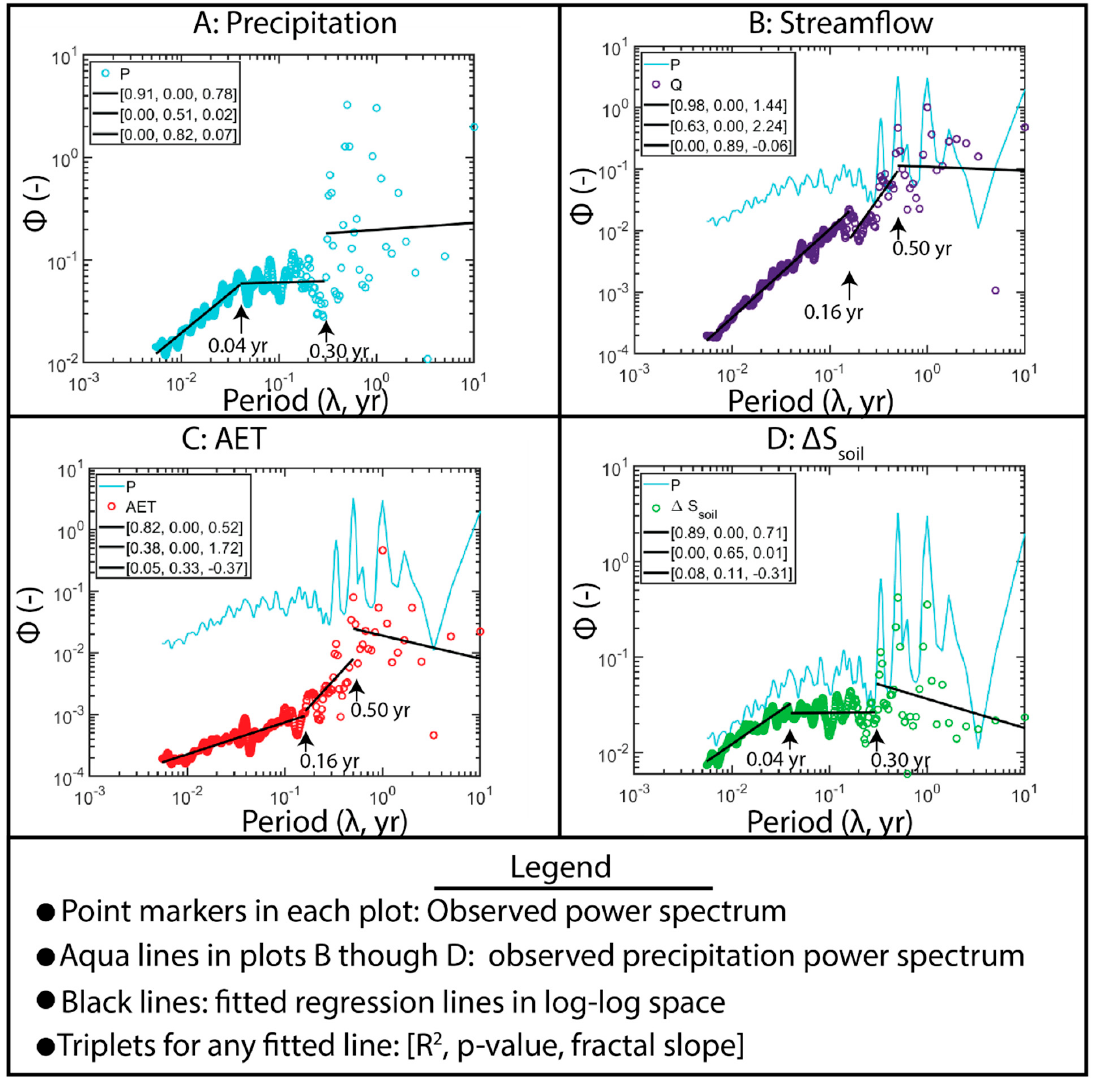
Figure 4. Observed power spectra for daily precipitation ( A ), daily streamflow ( B ), daily actual evapotranspiration ( C ), and daily change in soil water storage ( D ) between water years 2008 and 2017.